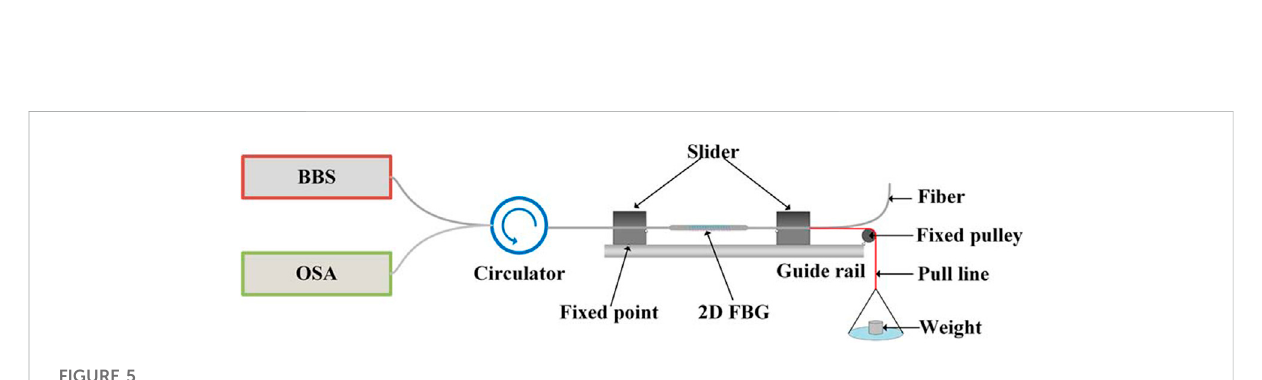
FIGURE 5 The schematic diagram for the strain sensing